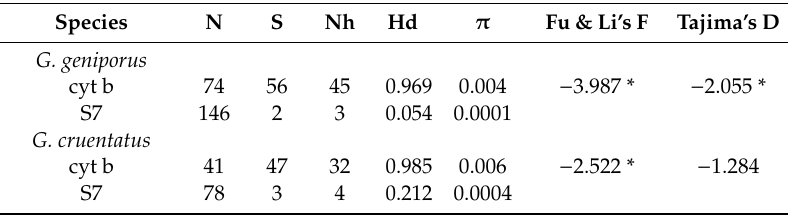
Table 2. Diversity measures and results of neutrality tests for Gobius geniporus and G. cruentatus based on cytochrome b and S7 sequences. N—number of sequences, S—number of segregating sites, Nh—number of haplotypes, Hd—haplotype diversity, π —nucleotide diversity. Significant values (at α = 0.05) indicated by